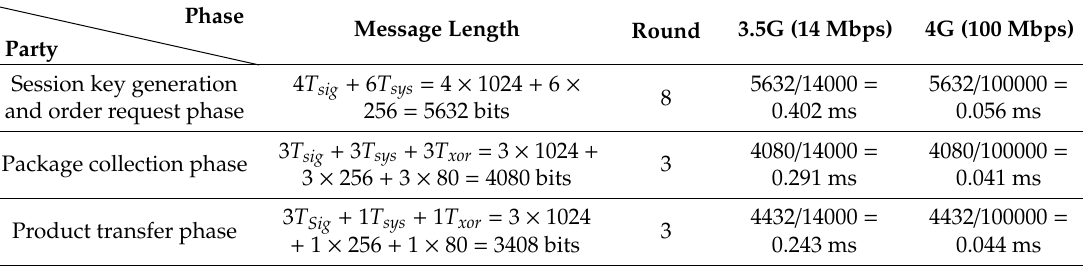
Table 3. Communication cost of the proposed